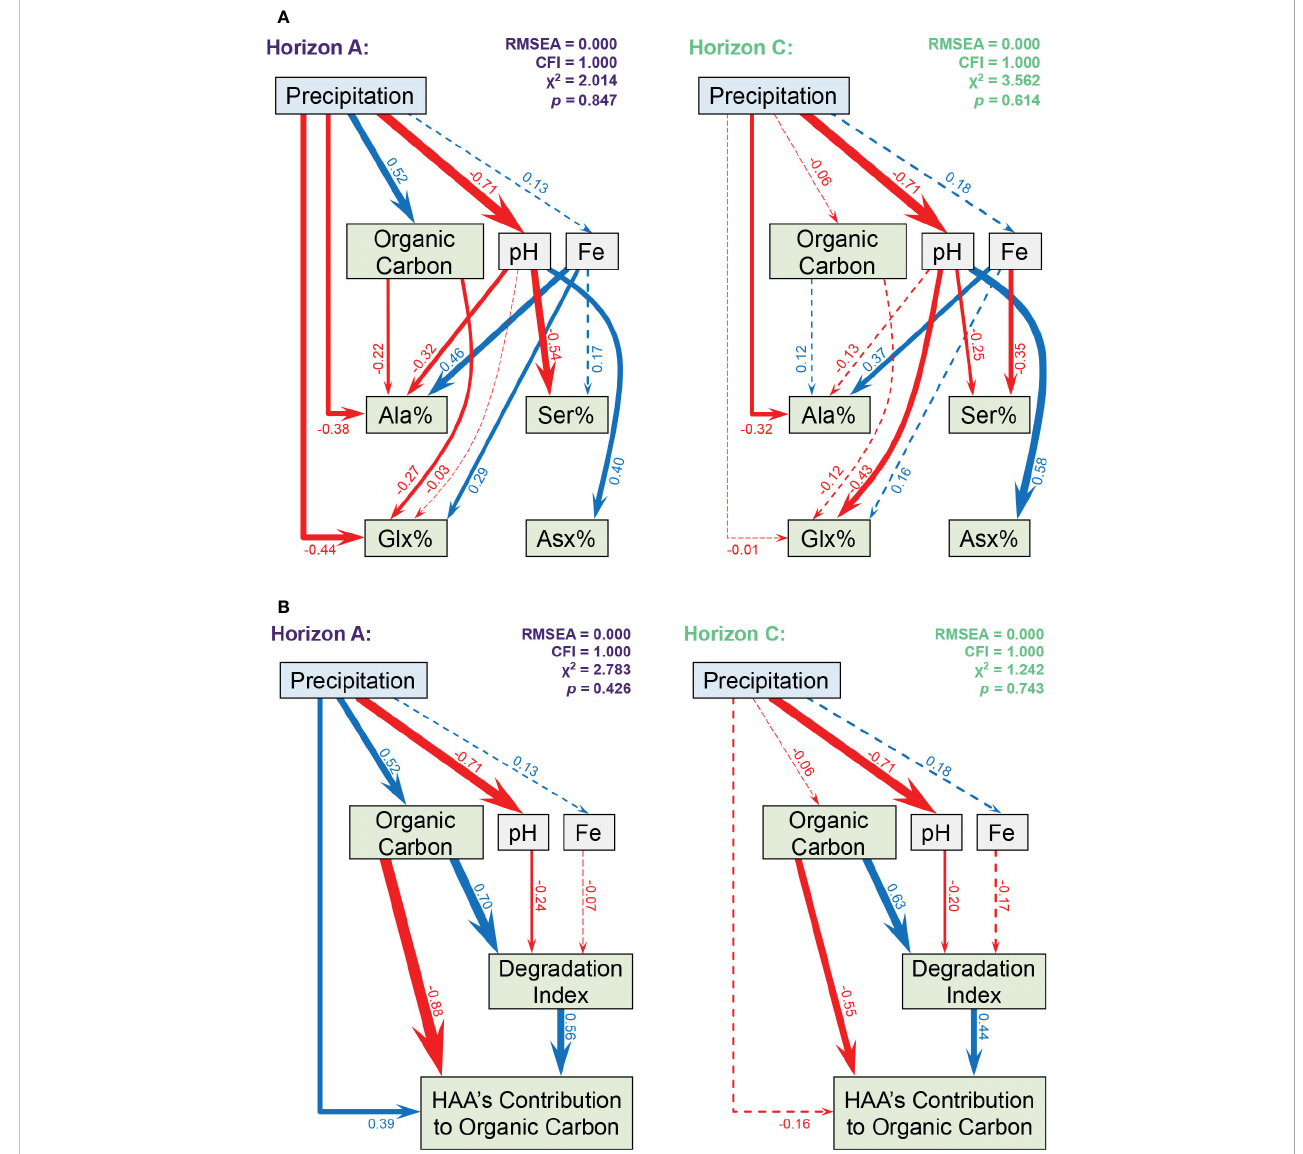
FIGURE 5 Model describing precipitation, but not temperature, as a proximate and distal mechanism controlling soil HAA composition Path diagrams comparing the direct and indirect effects of precipitation on (A) HAA composition and (B) HAA ’ s contribution to organic carbon pool in horizon A (n = 84) and horizon C (n = 81). Red and blue paths represent the negative and positive relationships, respectively. Solid and dashed paths indicate signi fi cant and insigni fi cant relationships, respectively. The paths ’ thickness is scaled based on the standardized path coef fi cients as shown adjacent to the